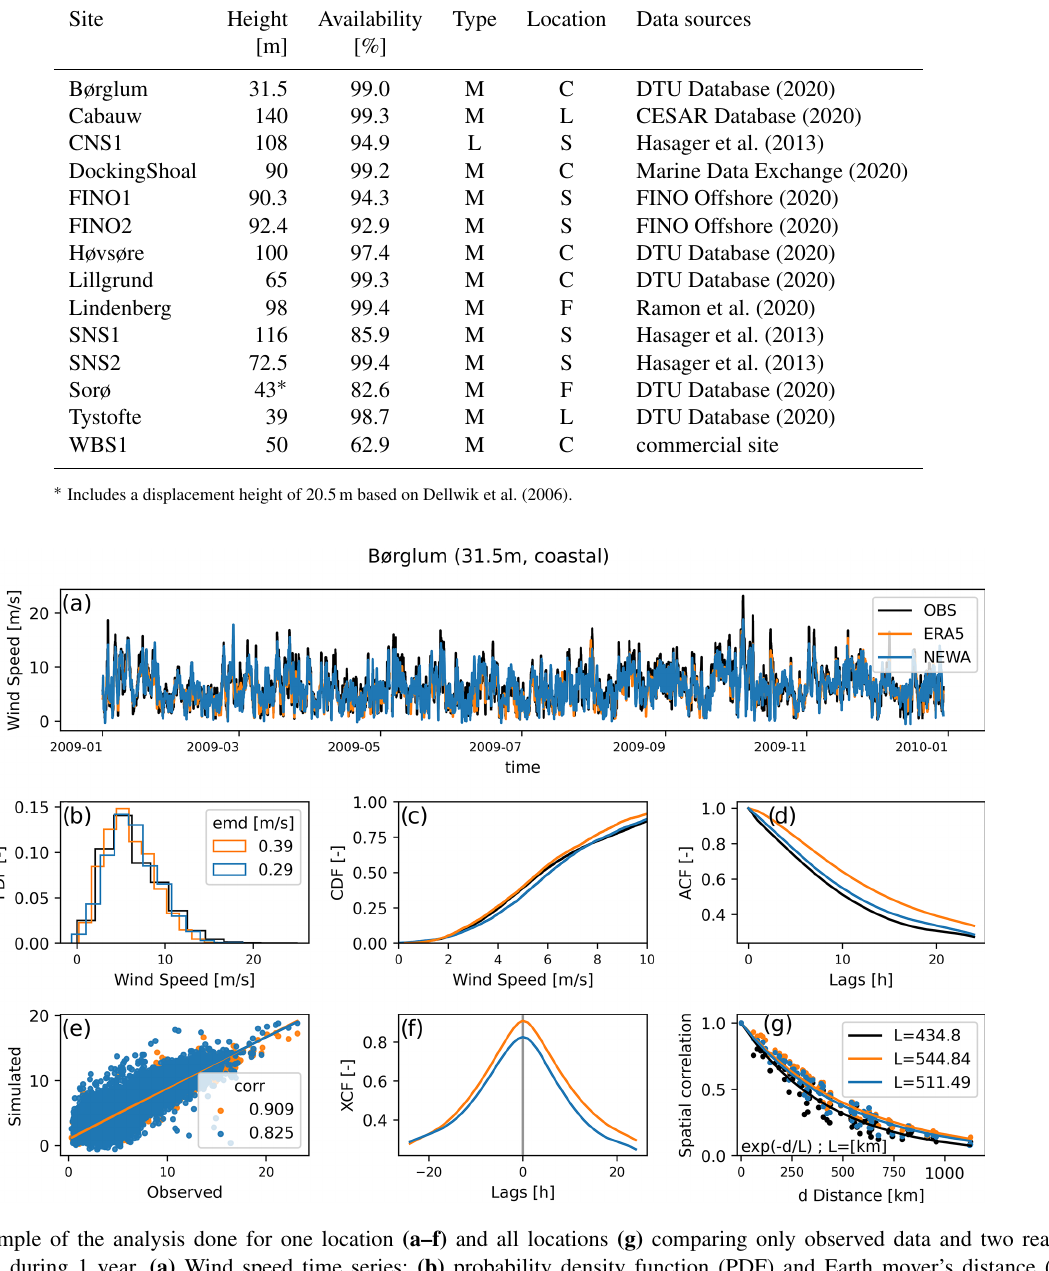
Table 2. Observational datasets. Type: meteorological masts (M), lidar (L); location: coastal (C), land (L), offshore (S), forest (F). Availabil- ity [%] refers to the valid data within time coverage during 2009 after the quality control and minimization of flow distortion.